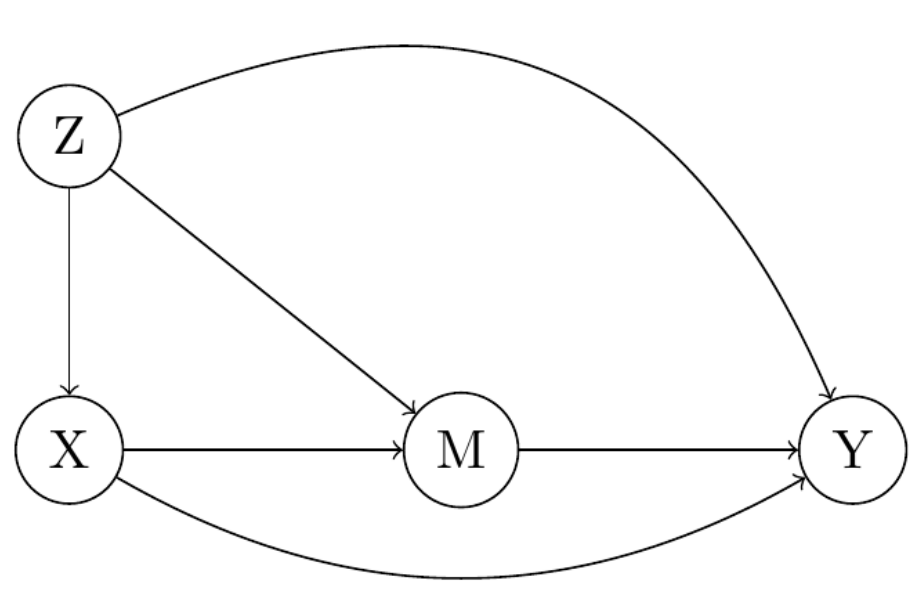
Figure 1: Causal relations between grandparent education (X), parental characteristics (M), and child cognitive ability